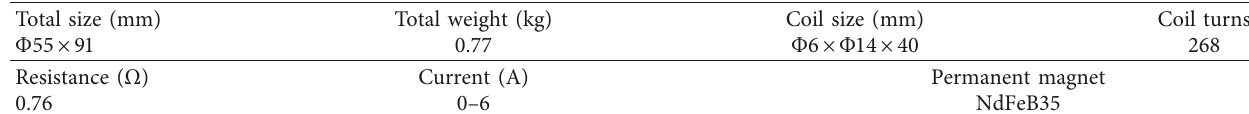
Table 2: Structural parameters of the joint mechanism.